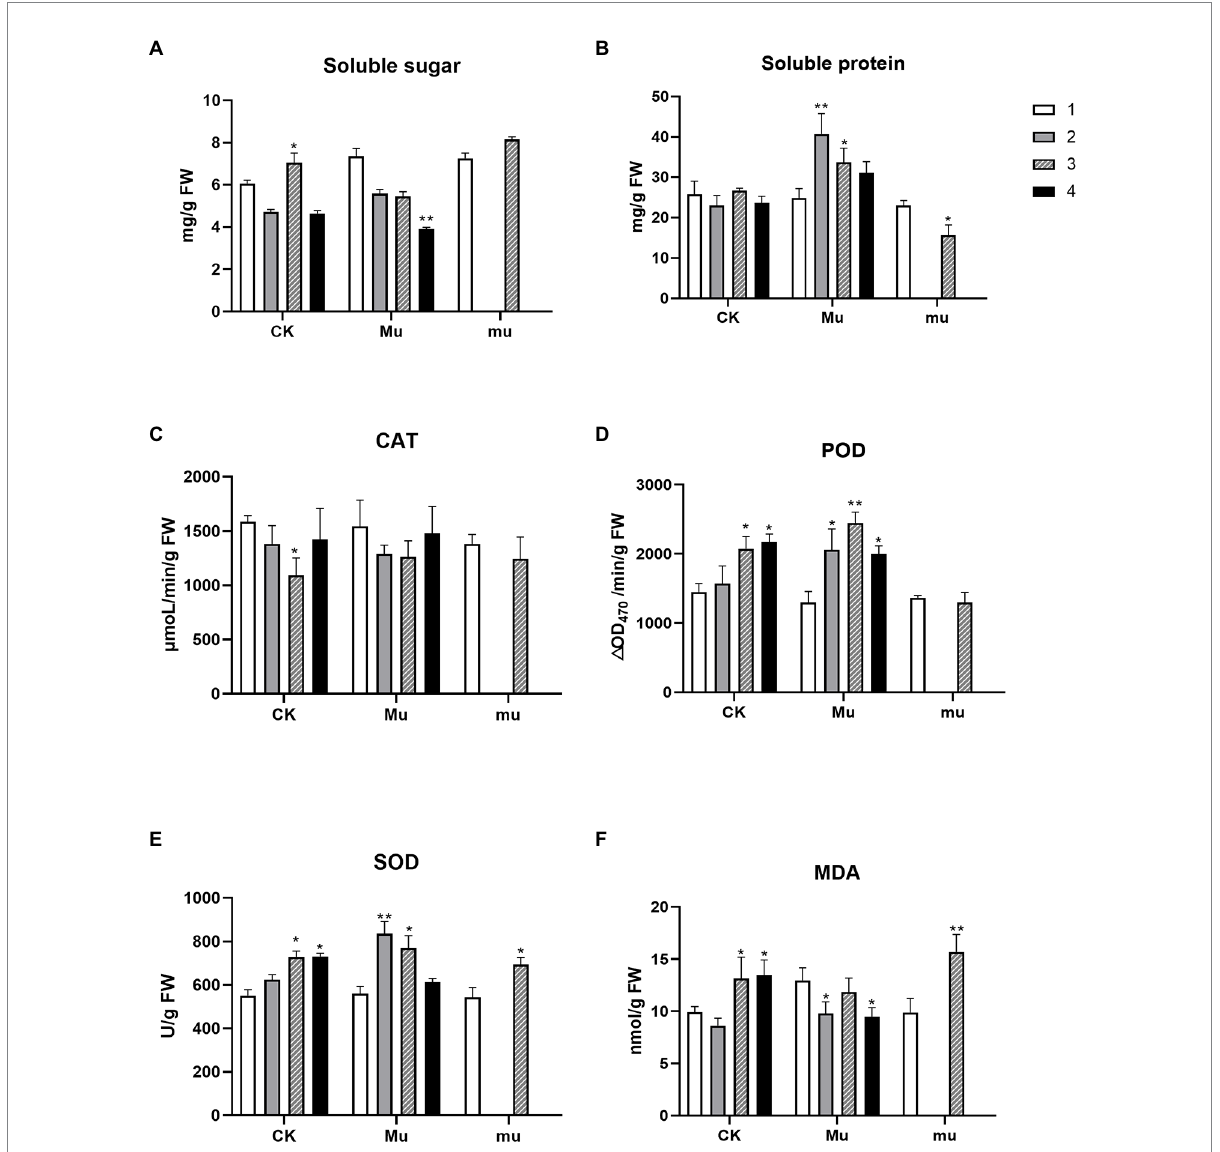
FIGURE 1 Physiological and biochemical changes of the three wheat lines during drought stresses and rehydration. Contents of soluble sugar (A) , soluble protein (B) , and MDA (F) and enzymic activities of CAT (C) , POD (D) , and SOD (E) of wheat under different treatments. The number 1–4 indicate different treatment. 1, pre-treatment; 2, moderate drought stress; 3, severe drought stress; 4, rehydration. Stars on the bar indicate significant difference as compared to the stage before drought. * p < 0.05, ** p <